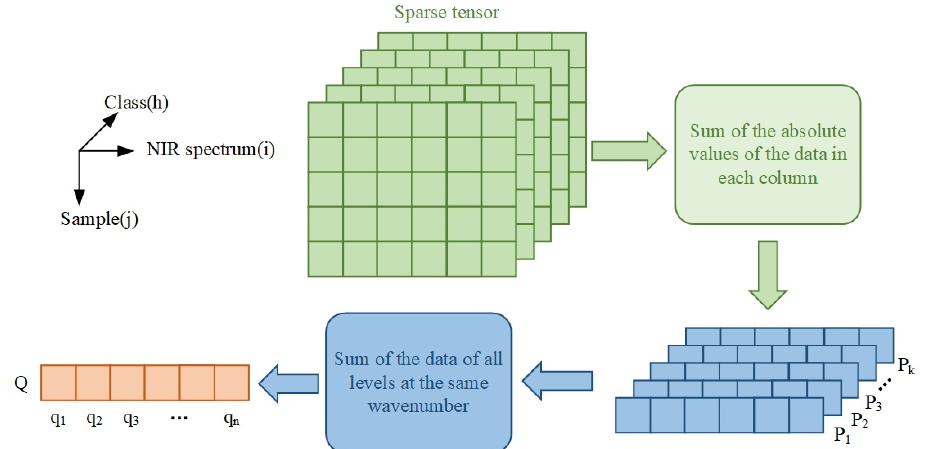
Figure 8. Characteristic spectrum extraction method based on sparse tensor.